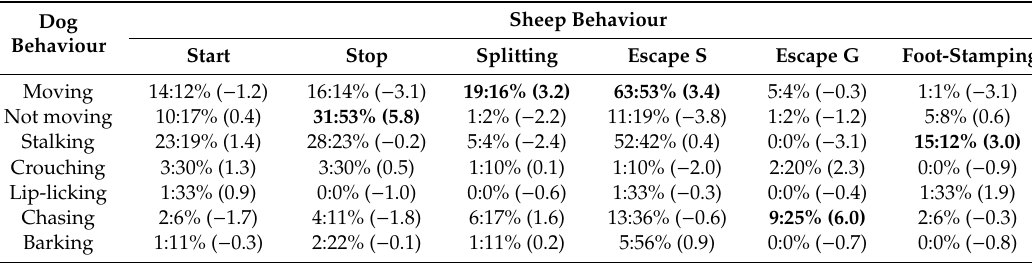
Each paired interaction details three results—Observed frequency: Conditional probability in percentage and adjusted residual in parentheses. Significant positive linkage between behaviours are highlighted in bold. Escape S: Escape single; Escape G: escape group. Table A3. Event-based lag sequential analysis results for dog behaviour response to sheep behaviour including observed frequencies, conditional probabilities and adjusted residuals.